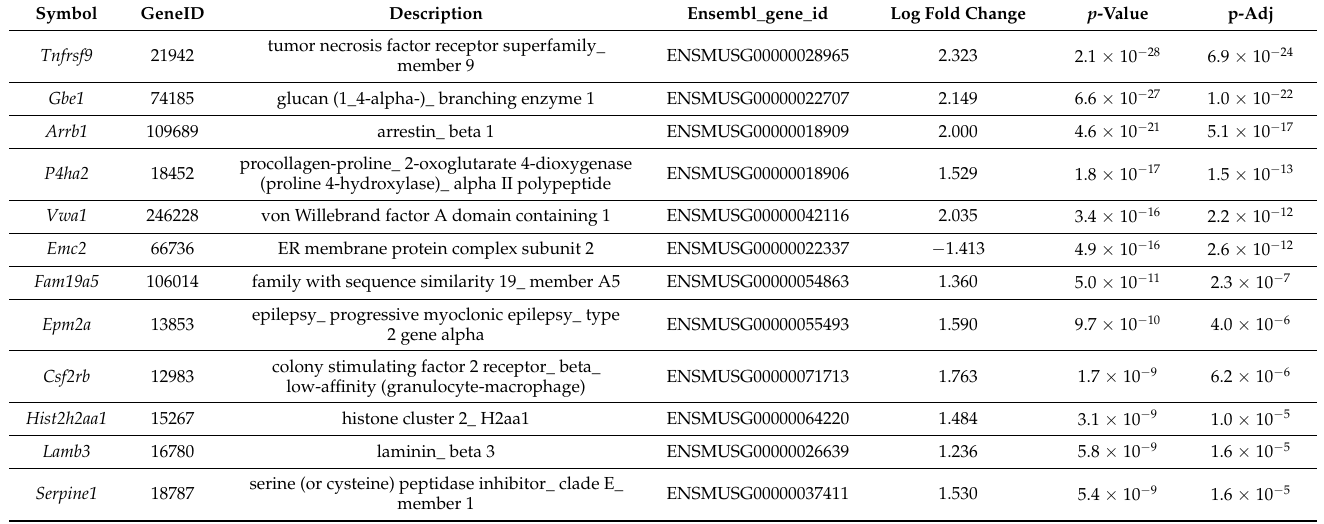
Table 1. Differential expressed genes (Log Fold Change <